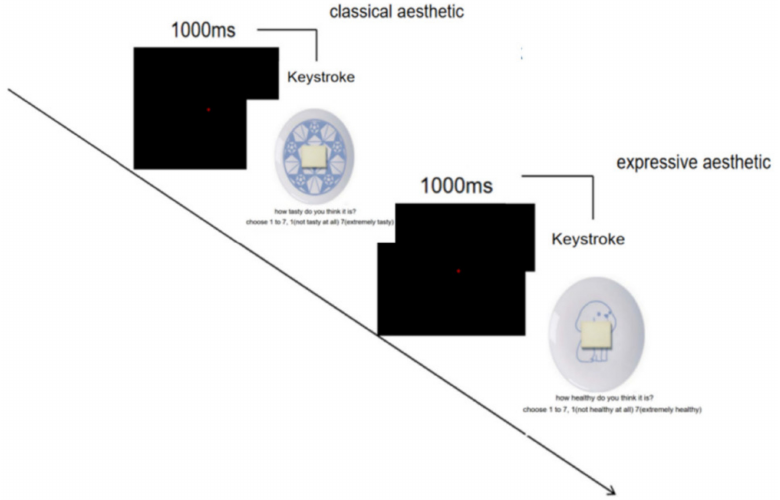
Figure 2. Flow chart of Experiment